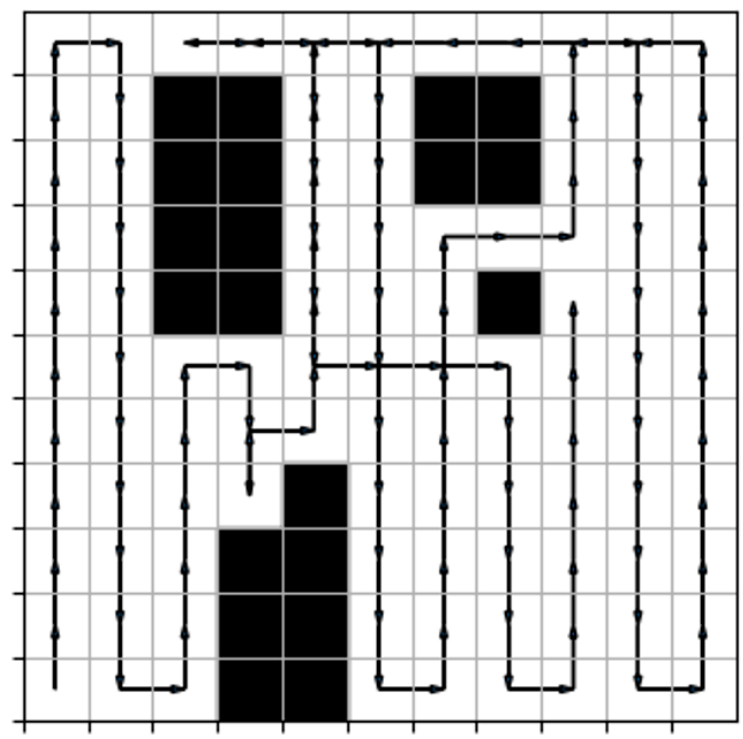
Figure 13. Path plan of